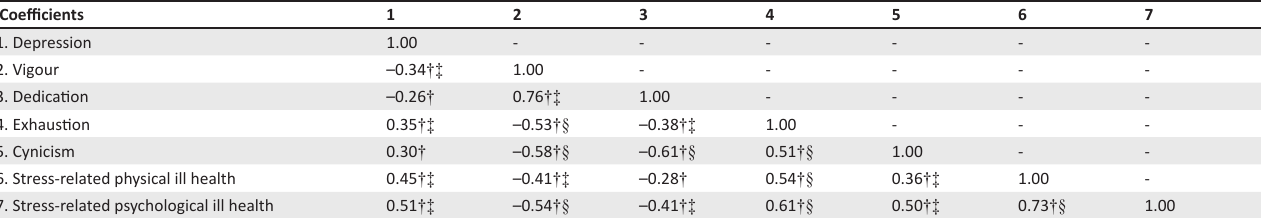
† , Correlation is significant at the 0.01 level. ‡ , Correlation is practically significant r > 0.30 (medium effect). § , Correlation is practically significant r > 0.50 (large effect).